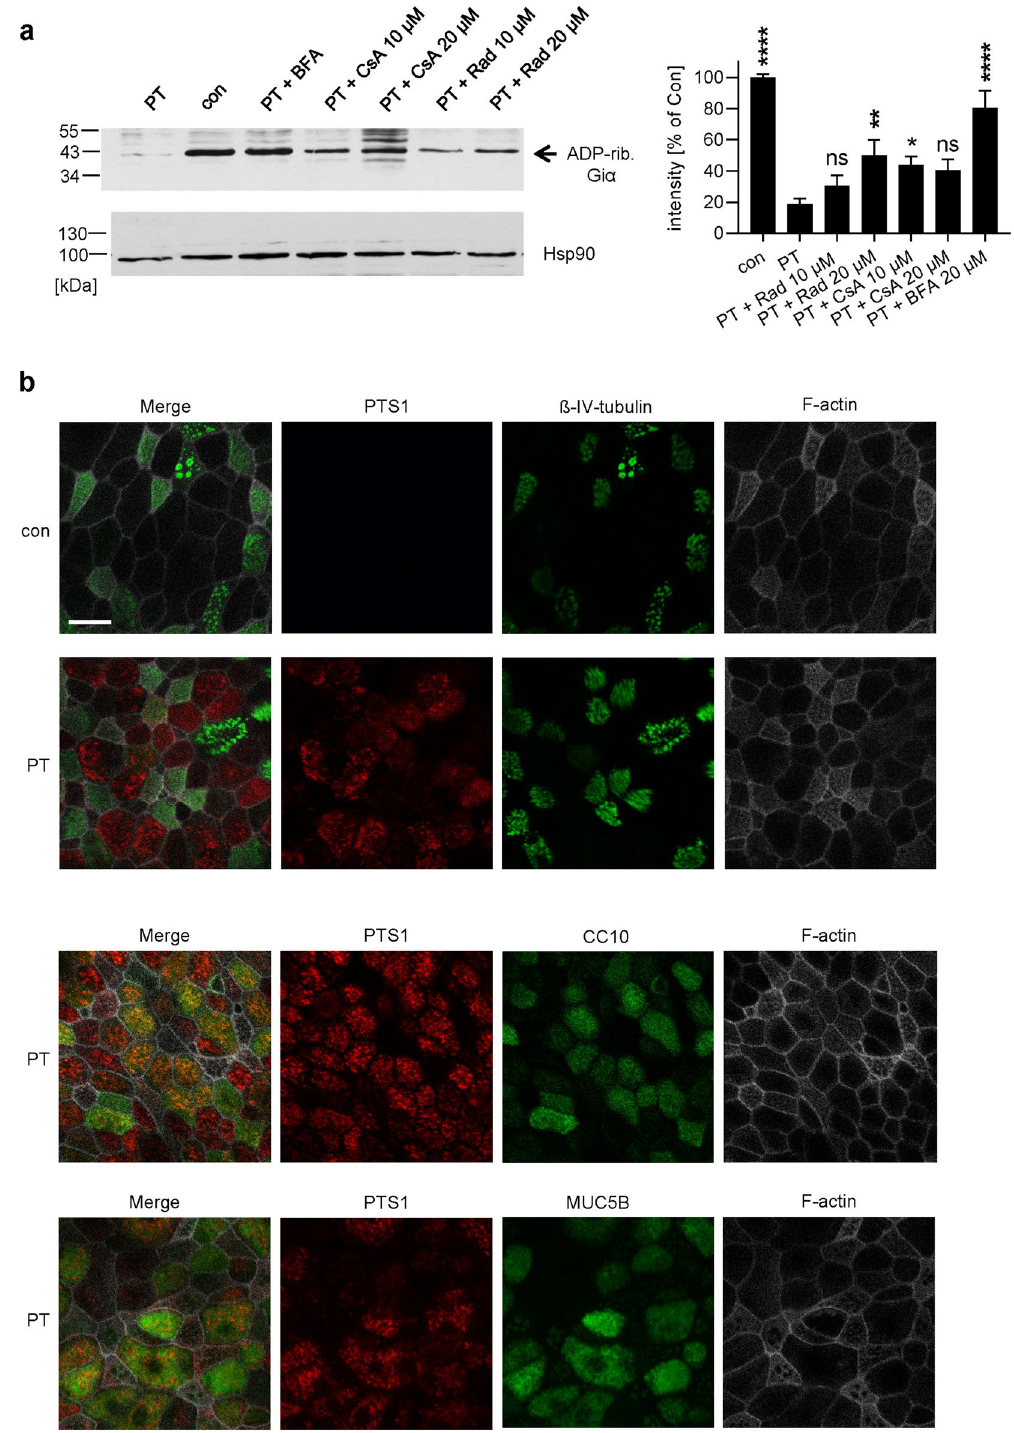
Figure 5. ( a ) Rad and CsA inhibit ADP-ribosylation of Giα in PT-treated basal cells. Basal cells were pre-incubated with Rad, CsA or BFA (20 µM) for 45 min or left untreated for control (con). Subsequently, 10 ng/ml PT was added for 4 h and the ADP- ribosylation status of Giα was determined as described before. A representative Western blot result is shown. Comparable protein loading was confirmed by Ponceau S (not shown) and Hsp90 staining. Western blot signals were quantified and normalized to protein loading (n = 8 independent experiments, mean ± SEM). Significance was tested by one-way ANOVA with Dunnett’s multiple comparisons test and refers to samples treated with PT only (****p < 0.0001, **p < 0.01, *p < 0.05, ns not significant). For uncropped blots see Supplemental Fig. S13. ( b ) PTS1 is detected in secretory (CC10+, MUC5B+) cells but not in ciliated (β-IV- tubulin+) cells. hBAECs were incubated with PT (20 µg/ml) from the apical side for at least 72 h or left untreated for control. Cells were fixed with 4% PFA. For permeabilization and quenching of autofluorescence, cells were treated with 0.2% saponin. F-actin was stained with phalloidin-FITC. PTS1, β-IV-tubulin, CC10 and Muc5B were stained with specific primary and fluorescence- labeled secondary antibodies, respectively. Pictures were taken with an inverted confocal microscope. Scale bar = 20